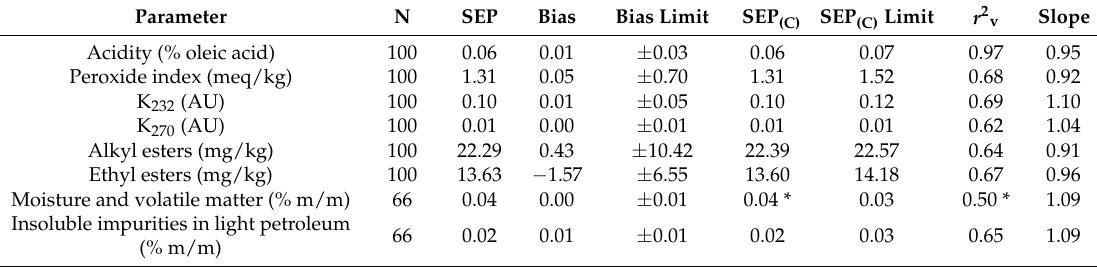
Table 4. Validation statistics for predicting quality parameters in olive oil using the FNS-6500 SY-I monochromator with dynamic (spinning module) sample